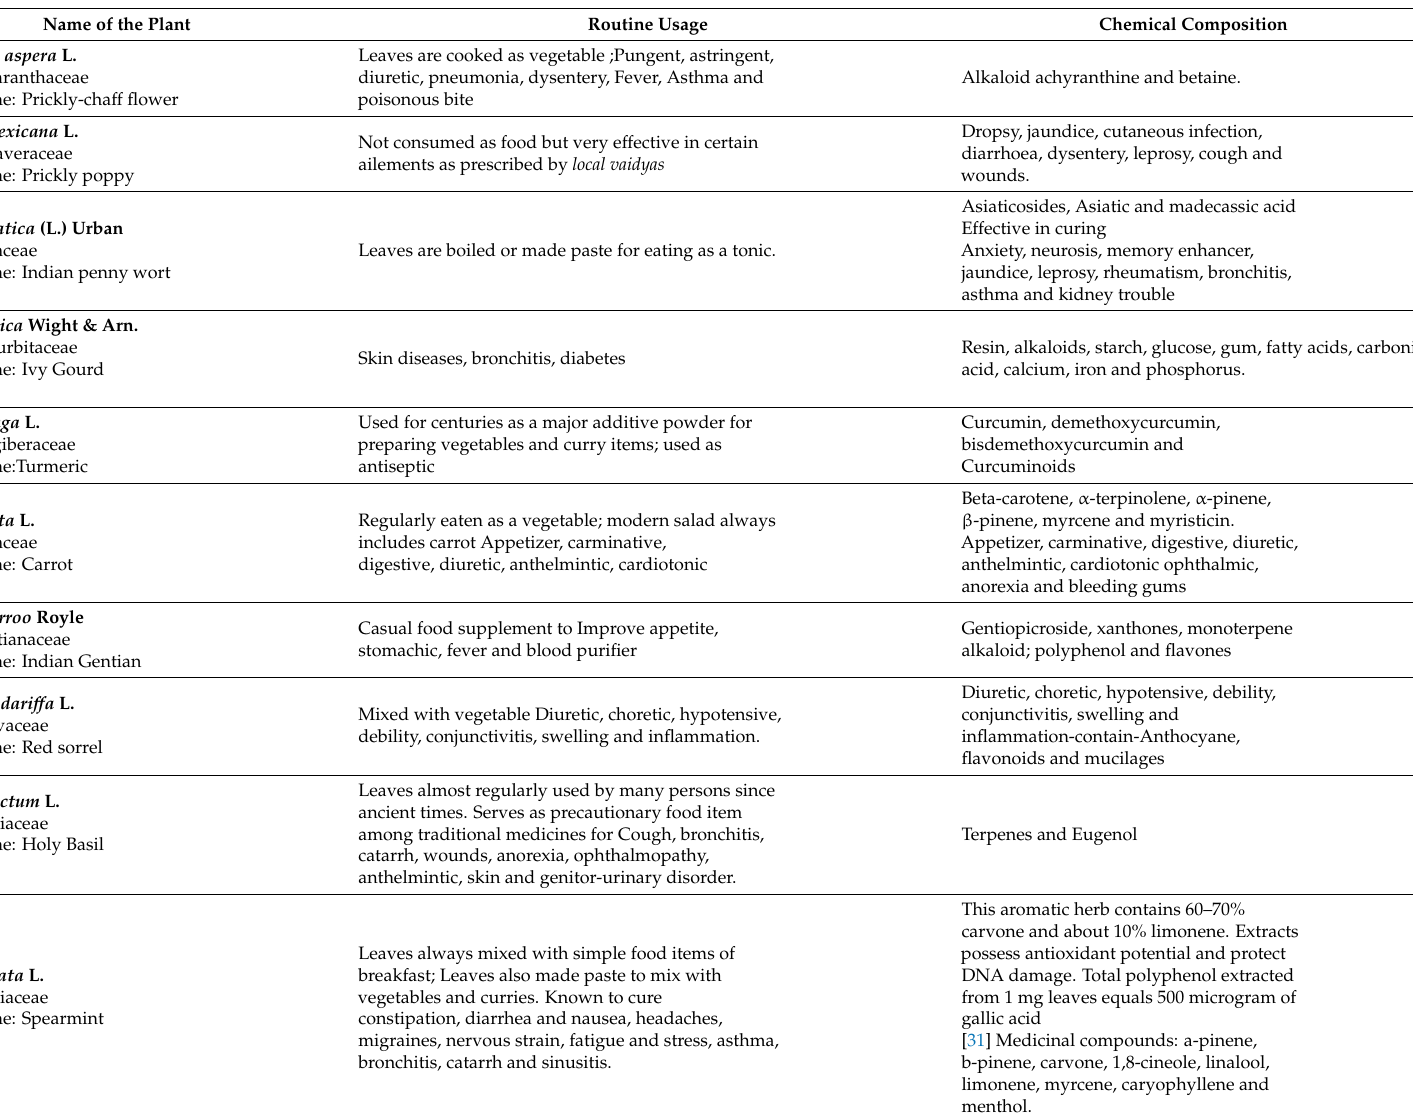
Table 2. Common wild plants (herbs) used as precautionary medicinal food—items by isolated population/tribes in